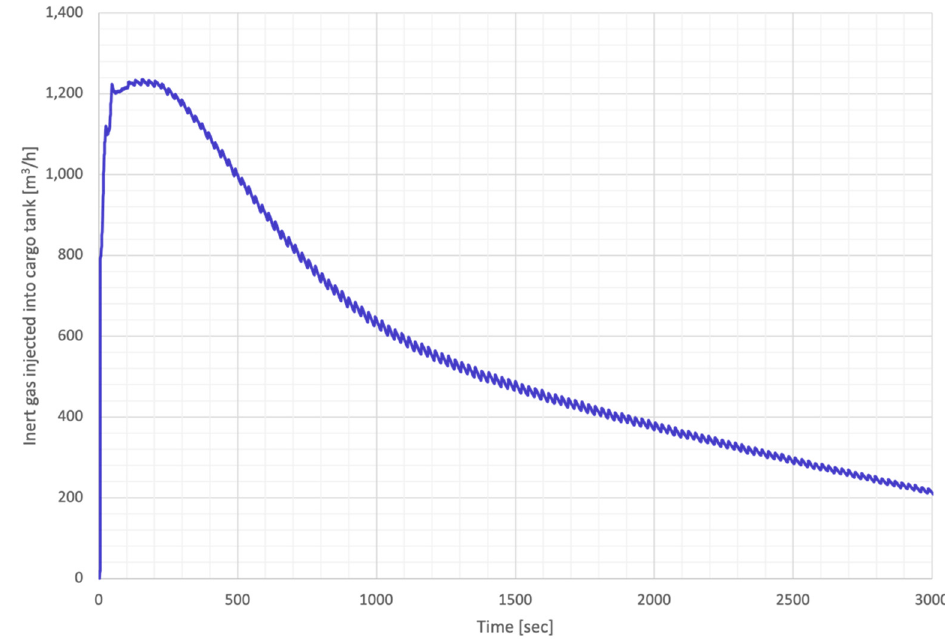
Figure 10. Inert gas flow rate injected into the cargo tanks.